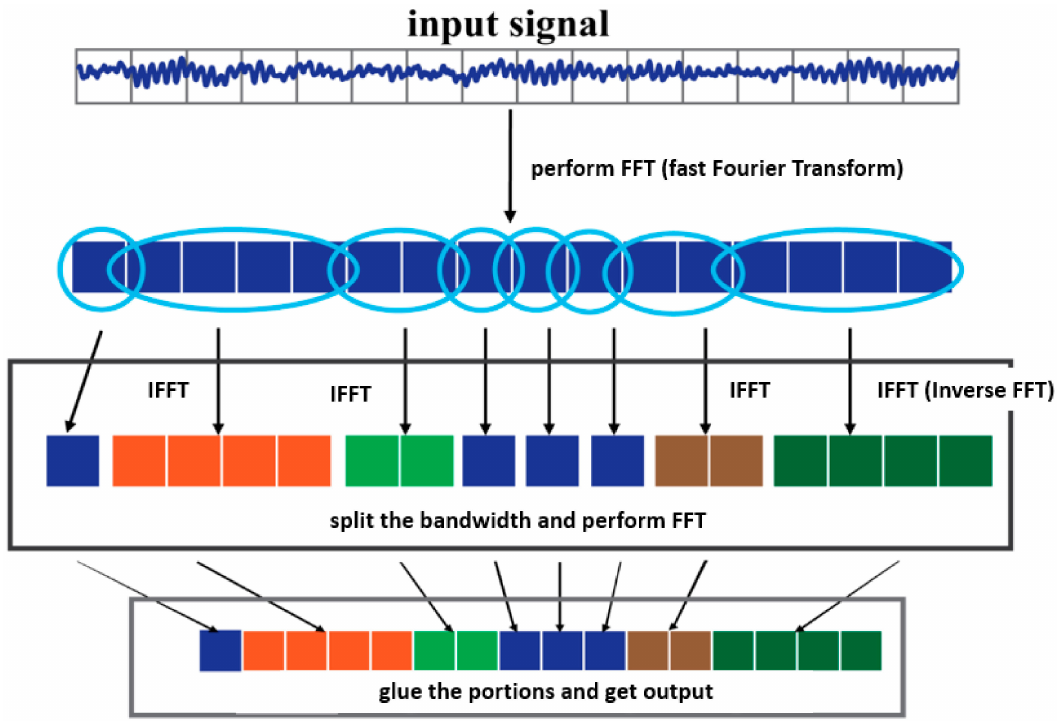
Figure 3. Discrete orthonormal Stockwell transform (DOST) basis construction process, where FFT stands for fast Fourier